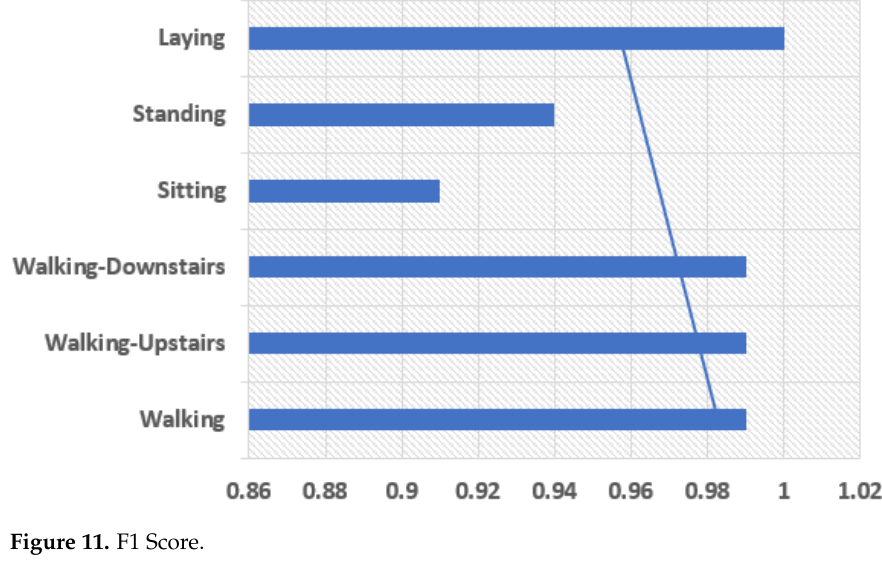
Figure 10. Precision.